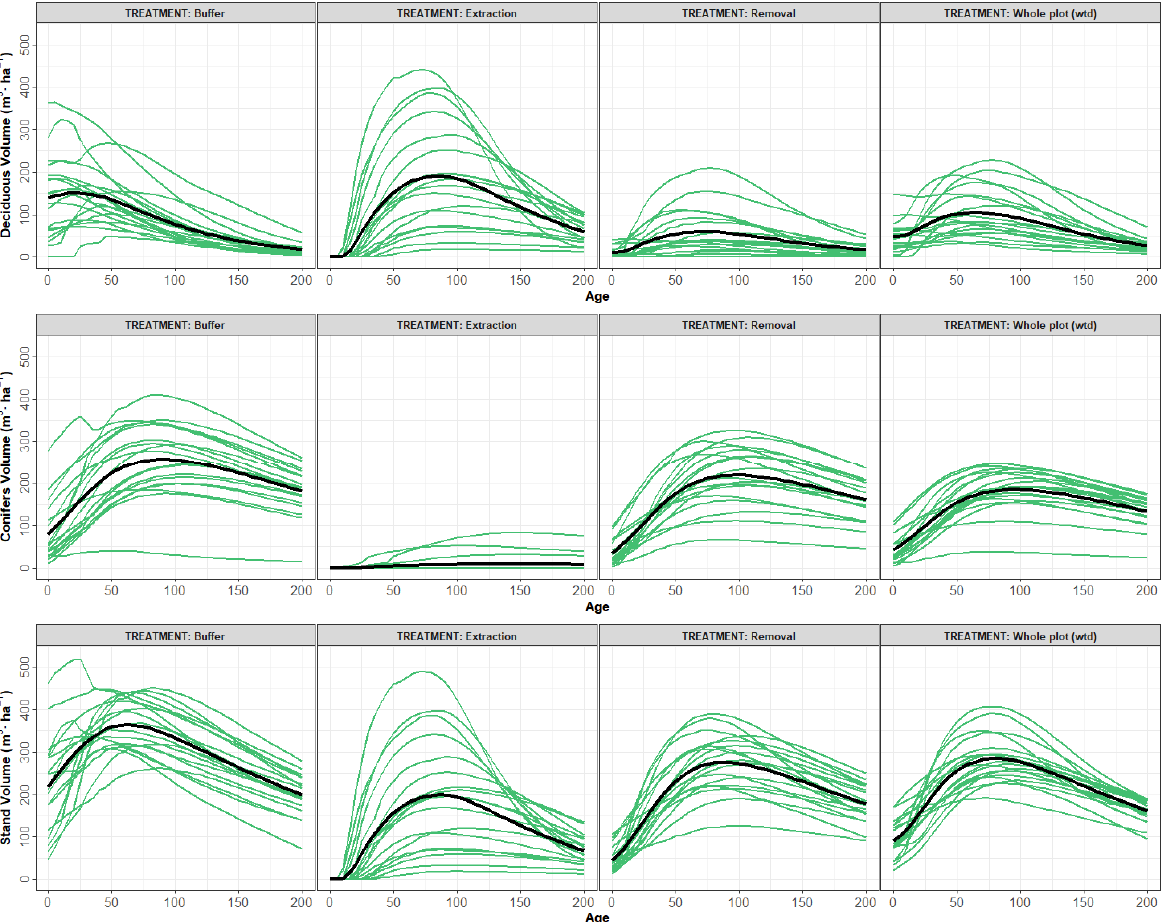
Figure 6. MGM growth projections of stand (merchantable) volume for each stratum and at the block (whole plot) level. Black bolded lines represent the mean trajectory for the 18 SCUP blocks. On the X-axis, age represents years after initiation of the simulations (10 to 12 years after SCUP harvest) for all treatments.